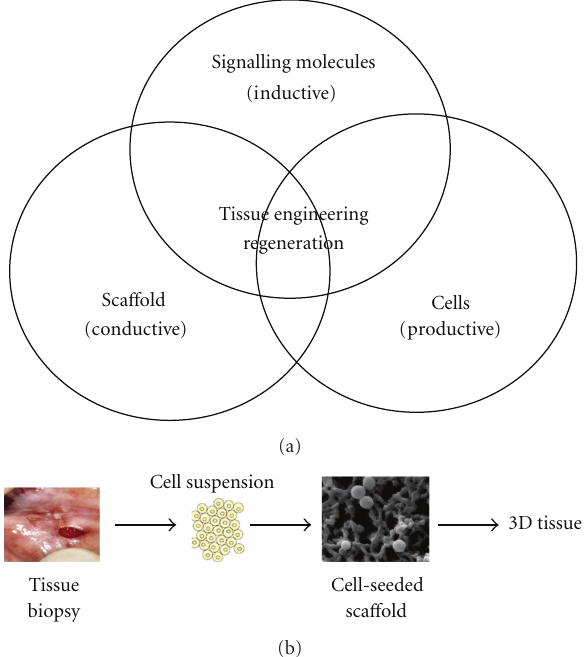
Figure 1: Tissue engineering strategy. (a) Basic principles of tissue engineering. (b) General methods of cell culture using a sca ff